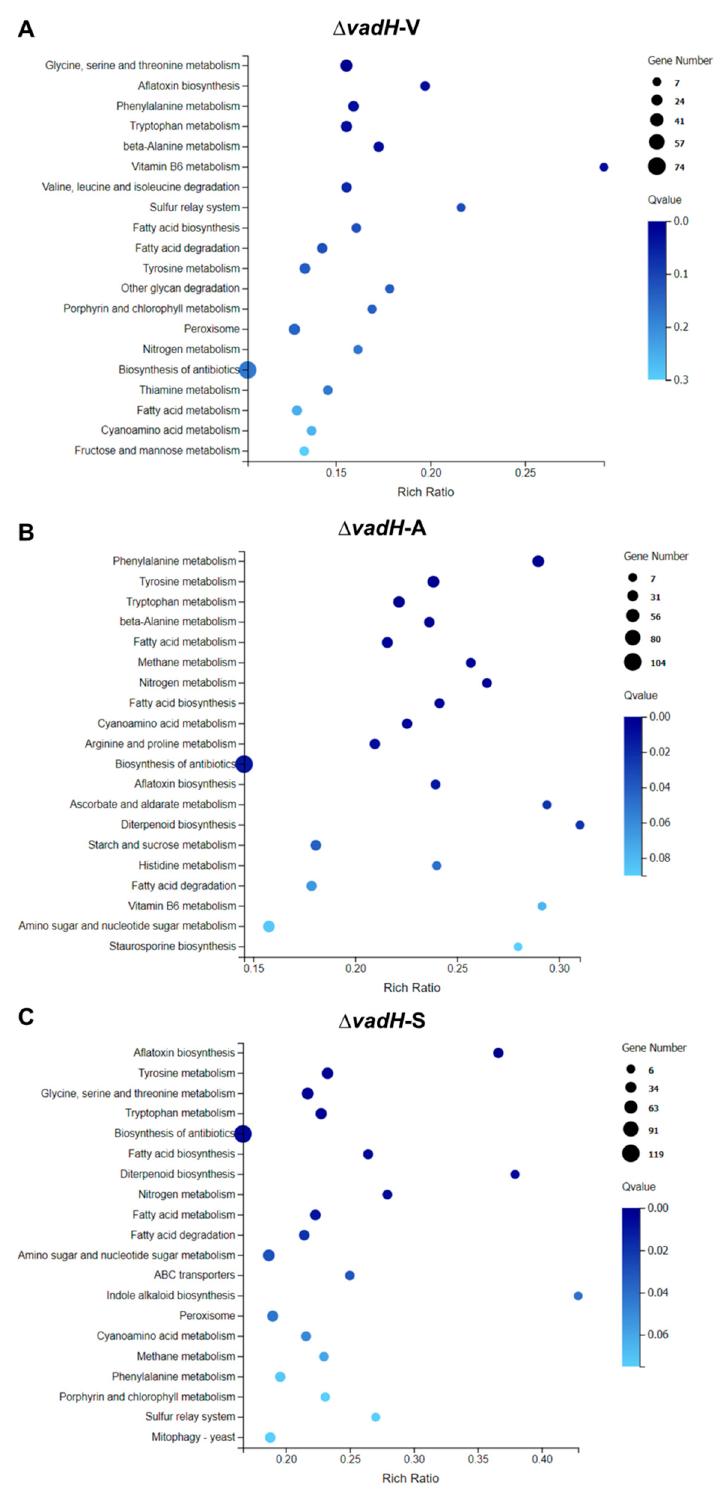
Figure 8. KEGG pathway enrichment of DEGs during the vegetative growth ( A ), asexual devel- opmental ( B ), and sexual developmental ( C )